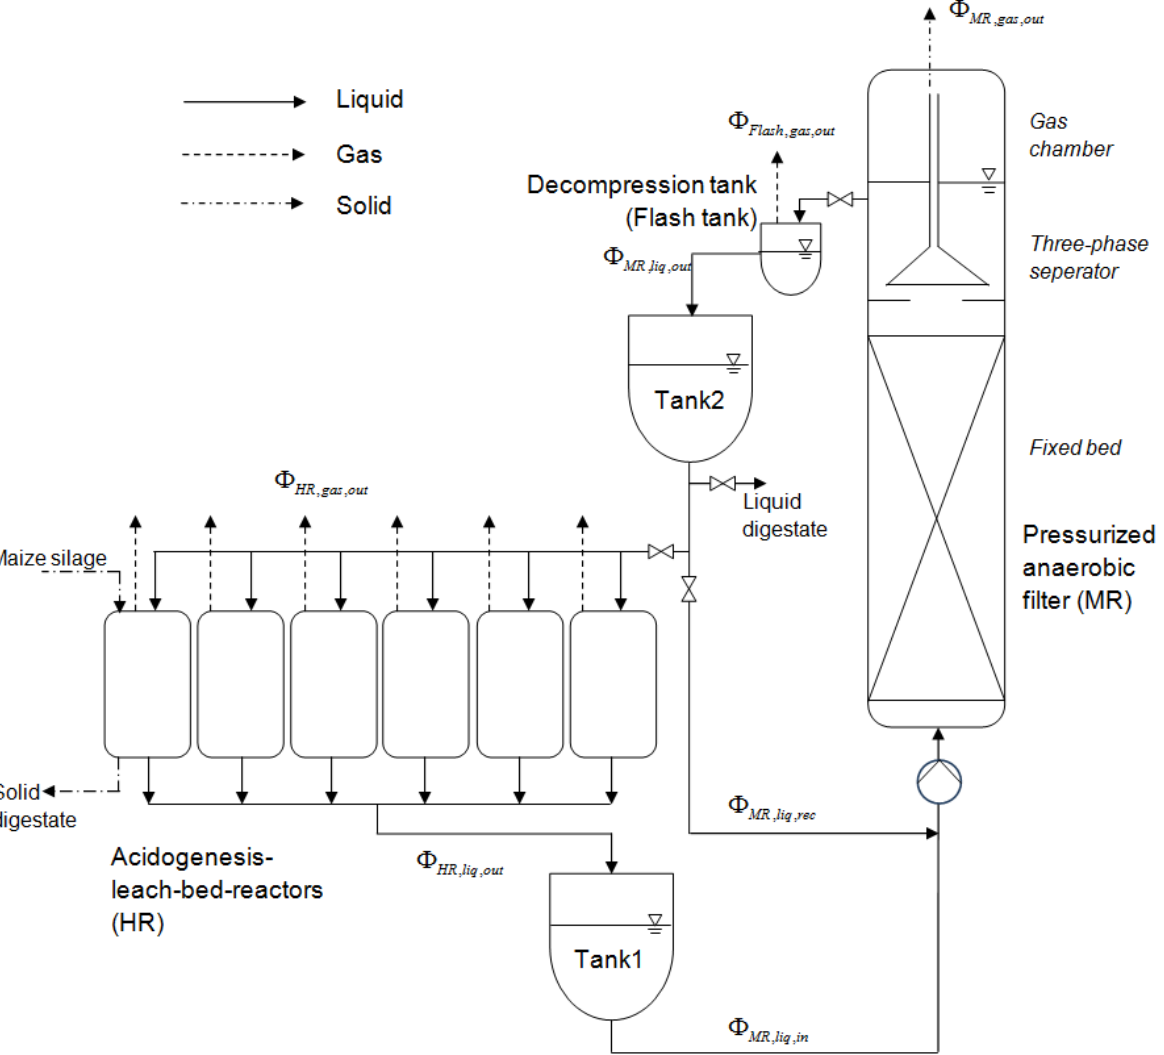
Figure 1. Schematic diagram of the two-stage pressurized anaerobic digestion system with: Φ liq : liquid flows; Φ gas : gas flows; Φ out : flows coming out of a reactor; Φ in : flows into a reactor; Φ rec : recirculated flows coming and going into the same